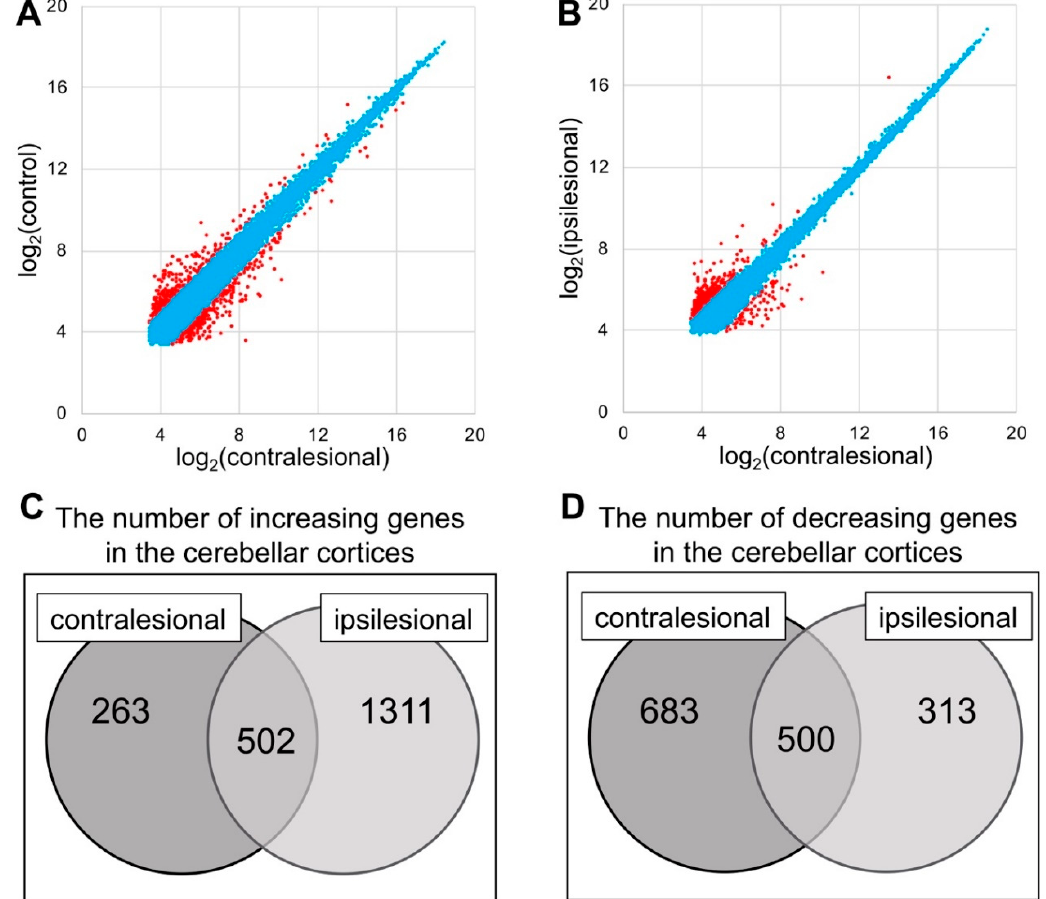
Figure 3. ( A , B ) Correlation plot of the contralesional, ipsilesional and control group. The genes with expression change between two conditions < 2.0 × are labeled as blue and ≥ 2.0 × as red. ( C , D ) The mRNA gene expression ratio was expressed as the ratio of the fluorescence intensity of the contra-or ipsilesional group to that of the control group. Increasing genes were defined as those for which Log2 (ratio) > 1 if the ratio was more than double, while decreasing genes were defined as those for which Log2 (ratio) < − 1 if the ratio was less than one-half.